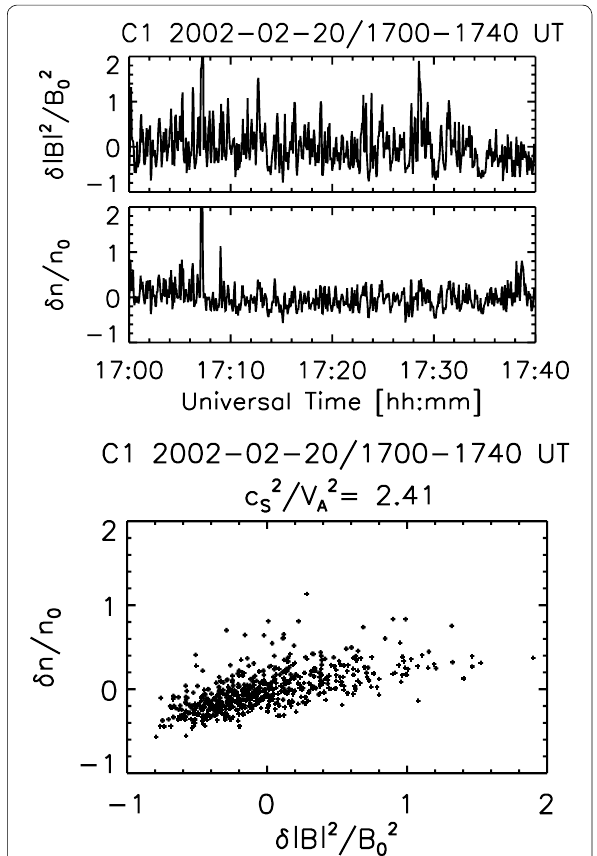
Fig. 2 The same panel style as Fig. 1 for a high-beta foreshock event on 20 February, 2002, 1700–1740 UT. Value of the ion beta is 2.41